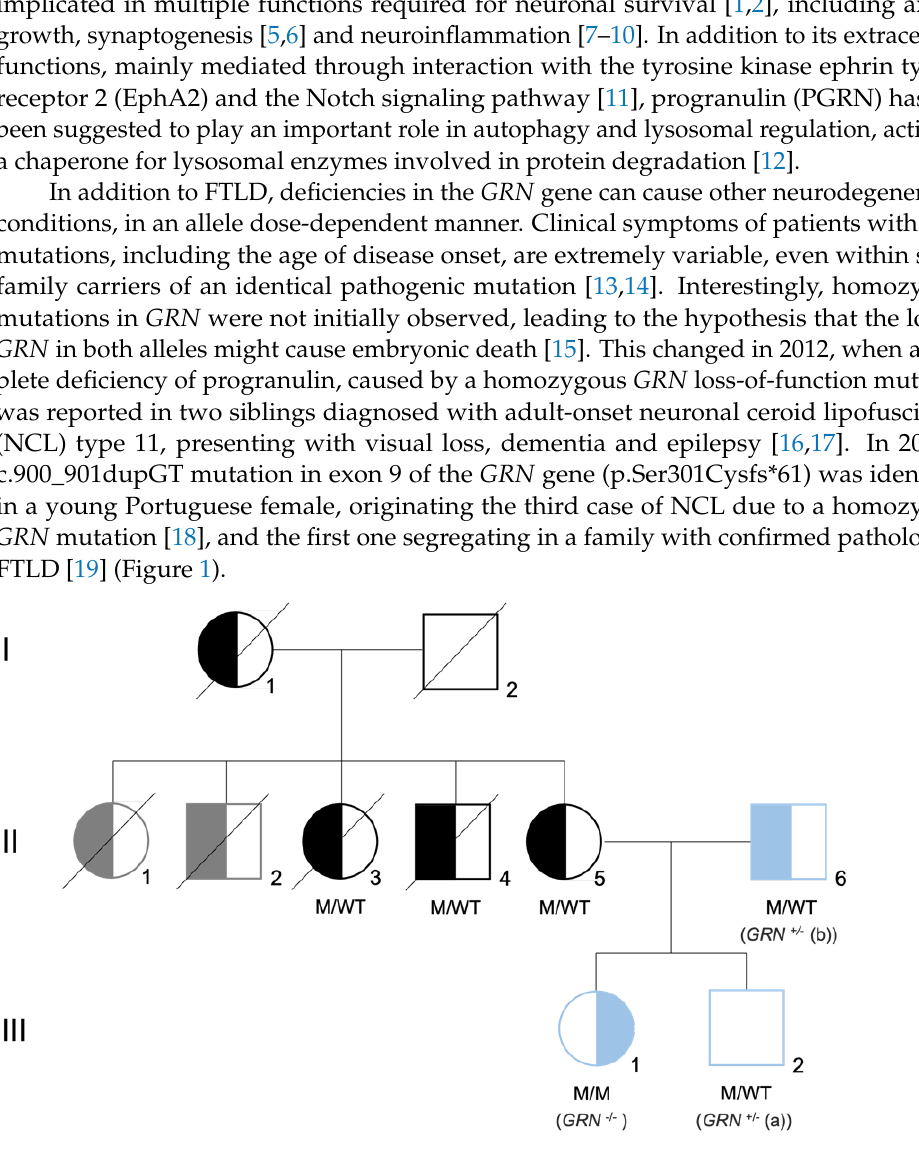
Figure 1. Family tree of the Portuguese family carrier of the GRN mutation. Family tree representative of the mutation status for GRN mutation c.900_901dupGT. Both parents (II5 and II6) are heterozygous for the mutation (M/WT), presenting with the behavioral variant of FTLD. The daughter (II1) is homozygous for the mutation (M/M), presenting with neuronal ceroid lipofuscinosis (CLN11). The son (II2) is heterozygous for the mutation (M/WT) and did not present symptoms at the time of the skin biopsy. Left-side filled black/blue symbols represent individuals diagnosed with behavioral variant of FTLD, while right-side filled black/blue symbols represent individuals diagnosed with neuronal ceroid lipofuscinosis. Left-side filled gray symbols represent signs of dementia plus Parkinsonism and the white square represents asymptomatic individuals. The generation is indicated by Roman numerals on the left side of the tree. The samples used in this study are represented in blue and are referred as GRN +/ − (a), GRN +/ − (b), and GRN − / − . Image adapted from [18,19].